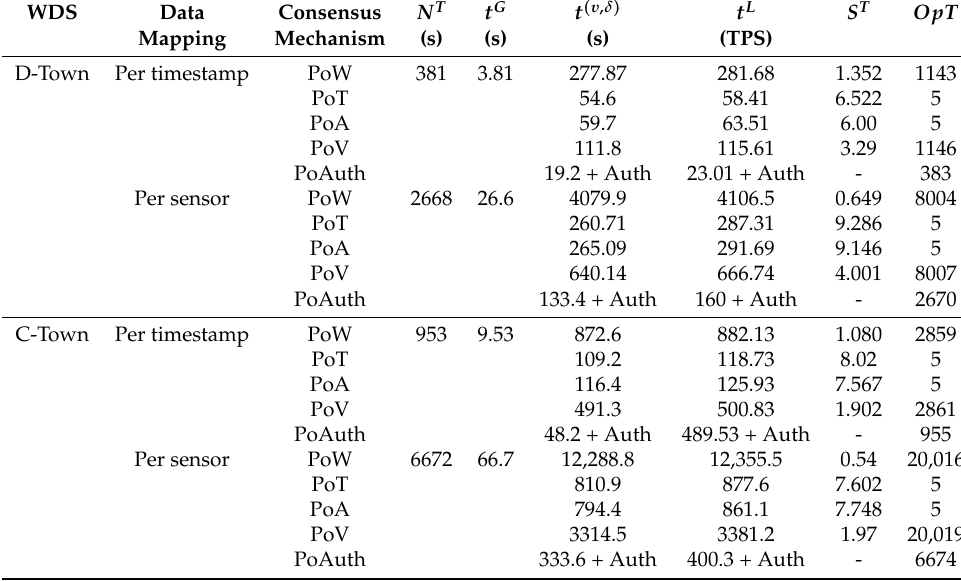
Table 4. The calculated performance for dynamic